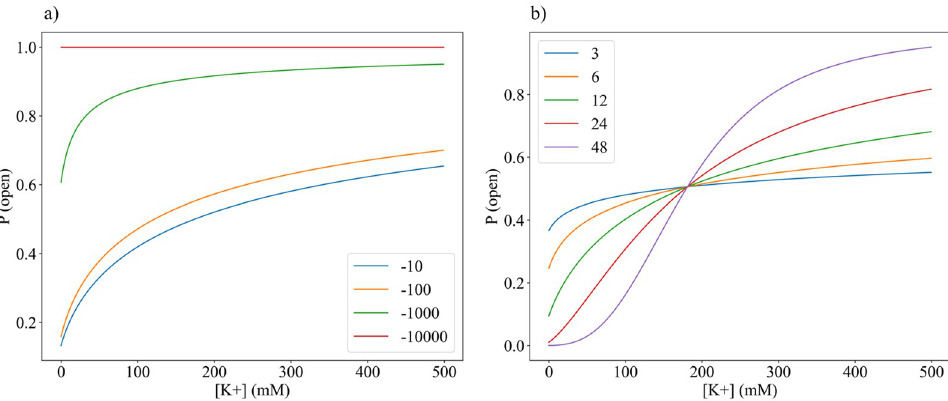
Fig 2. Changes in P ( open ) curves depend on standard free energy Δ G ˚ with values of − 10, − 100, − 1000, and − 10000 kcal/mol (a), and increasing gating charge q with values of 3, 6, 12, 24, and 48 e (b). The curves in (b) intersect at coordinate (181, 0.505). The [K+] domain [0 500] mM used matches the dynamic range of the channel so as to show the full range of behavior of the